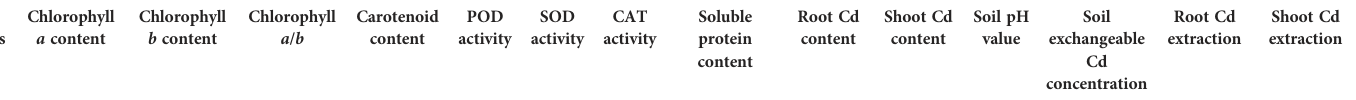
TABLE 3 Correlations among the different